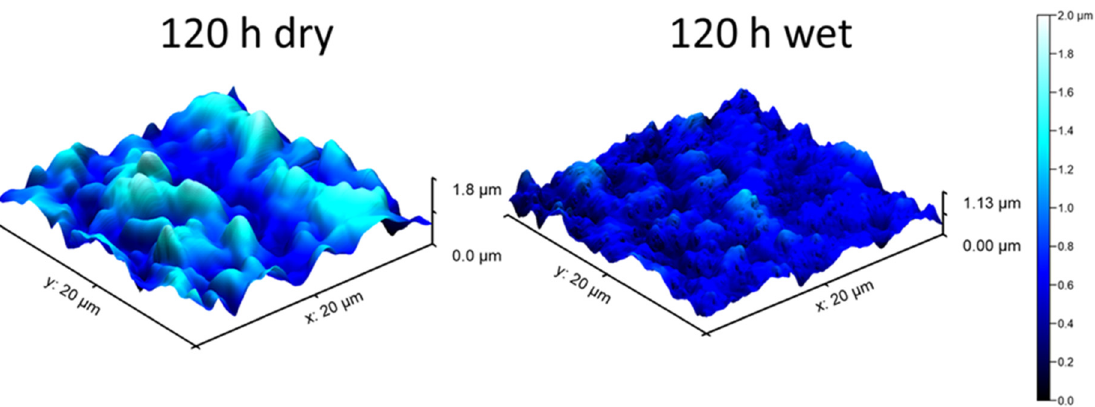
Figure 4. Surface topography of the 718Plus superalloy after oxidation at 850 ◦ C for 120 h of in dry and wet air;